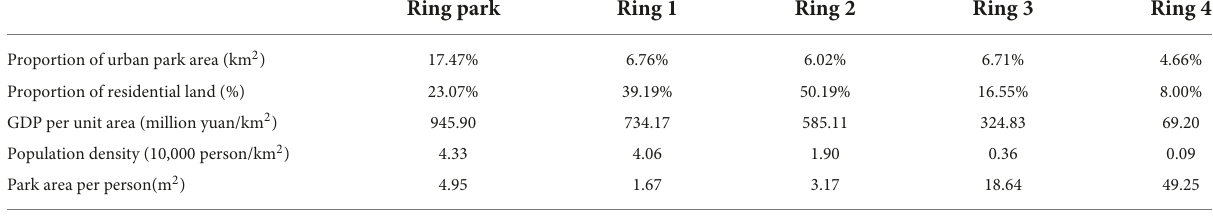
TABLE 3 Statistics of park and socioeconomic status in different rings. Ring park Ring 1 Ring 2